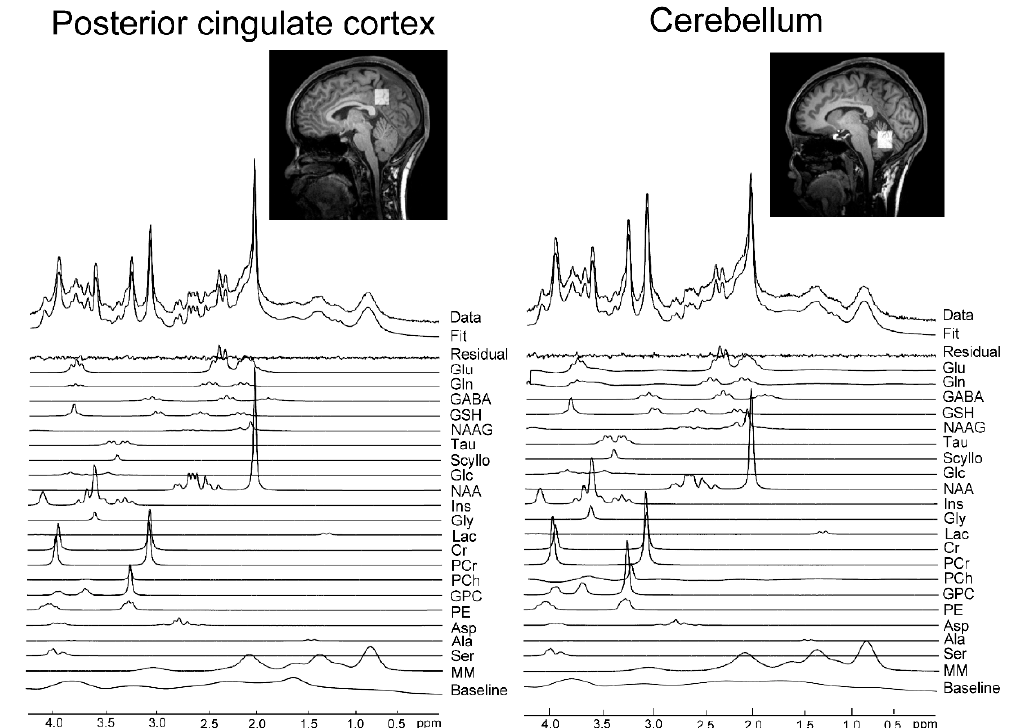
Figure 1. Representative spectrum in posterior cingulate cortex (PCC) and cerebellum (Cbll). Volumes of interest (VOIs) of MRS were localized at PCC and Cbll with the following voxel volumes: VOI 20 × 20 × 20 mm 2 for PCC, and 25 × 25 × 20 mm 2 for Cbll. A representative magnetic resonance (MR) spectrum acquired with the SPECIAL sequence at 3T (TE / TR = 8.5 / 3000 ms, number of averages = 128), the corresponding LCModel spectral fit, fit residual, macromolecules (MM), baseline and individual metabolite fits including glutamate (Glu) and glutamine (Gln).